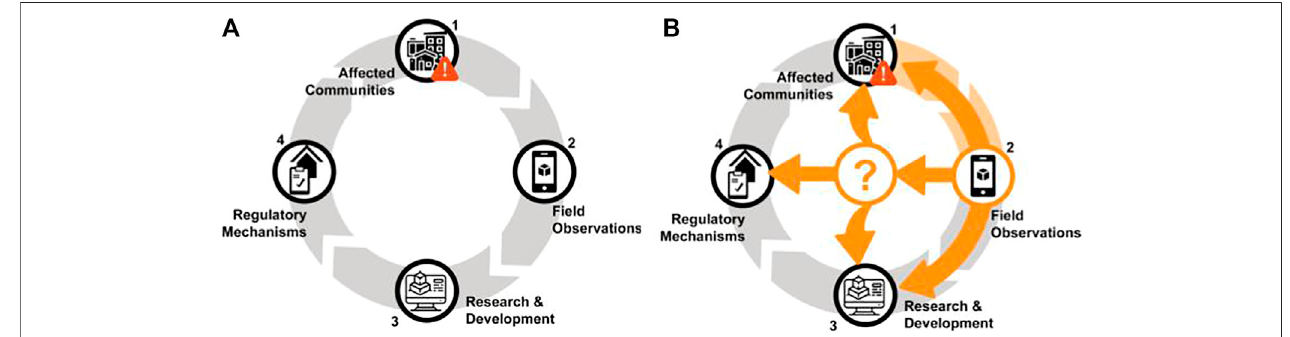
FIGURE1| DatatoKnowledgeLifeCycle: (A) traditional4-stepcycleingreyand (B) opportunitiesforFieldObservationorganizationsworkingin fi rstquarterofthe life cycle to accelerate feedback process through new conduits in orange.